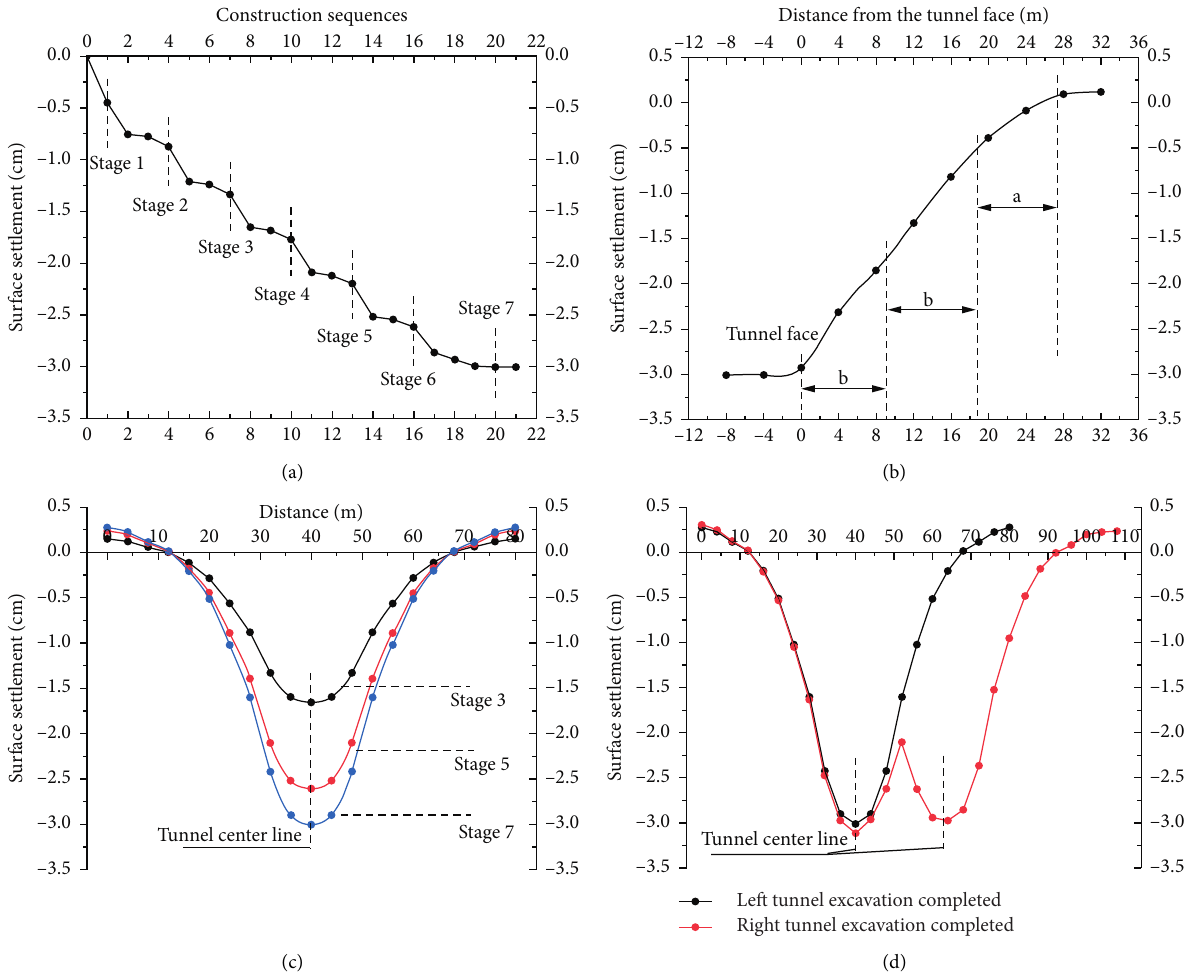
Figure 10: Surface settlement characteristics (tunnel face: section x � 50m). (a) Surface settlement with construction sequences, (b) surface settlement with distance from the tunnel face, (c) surface settlement troughs with construction sequences, and (d) whole surface settlement